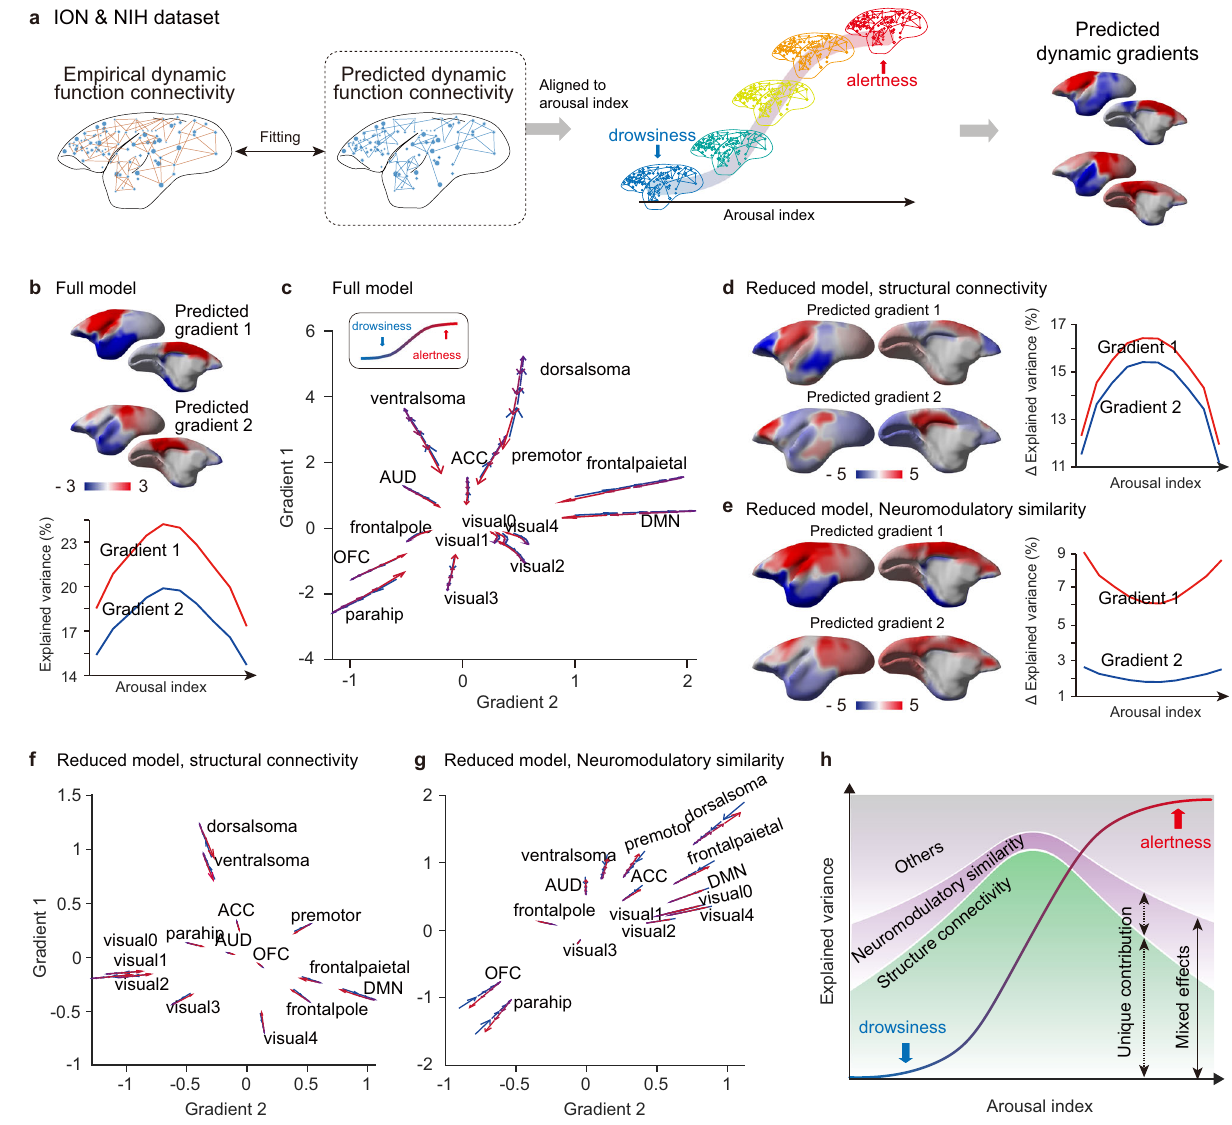
Fig.5|Opposingeffectsongradientdynamicsbetweenstructuralconnectivity and ascending neuromodulatory system. a Pipeline for the dynamic function gradients prediction. Brie fl y, we fi tted the empirical dynamic function con- nectivity (dFC) frame-by-frame utilizing the same GLM strategy as Fig. 4a. After binned by the arousal index, the predicted dFC matrices were averaged and projected into dynamic function gradients, respectively. b Predicted dynamic function gradients and corresponding explained variances (Full model). Details were shown in Supplementary Fig. 23. c Arousal relevant fl ow of each network in